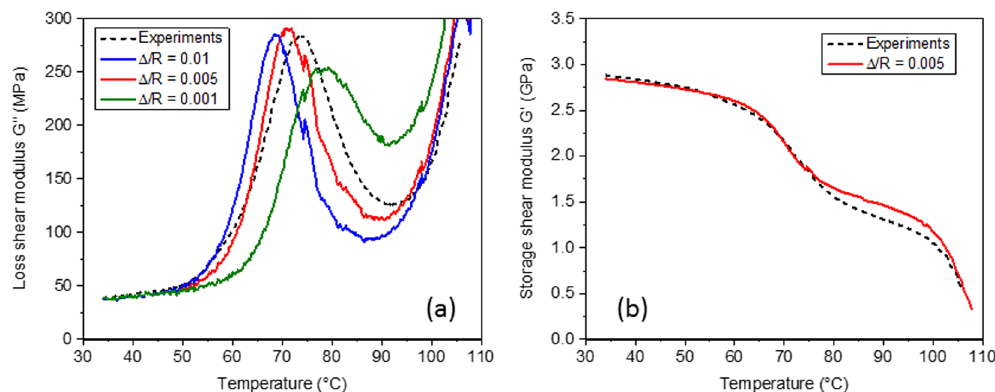
Figure 4. Numerical predictions for the three component system – bead fraction c = 0.35. ( a ) Numerical temperature scans for loss shear modulus G ″ at constant Δ / R values (0.01, 0.005 and 0.001) compared to the experimental measurements, which is the dotted black line. ( b ) Temperature scans for storage shear modulus G ′ at Δ / R = 0.005.